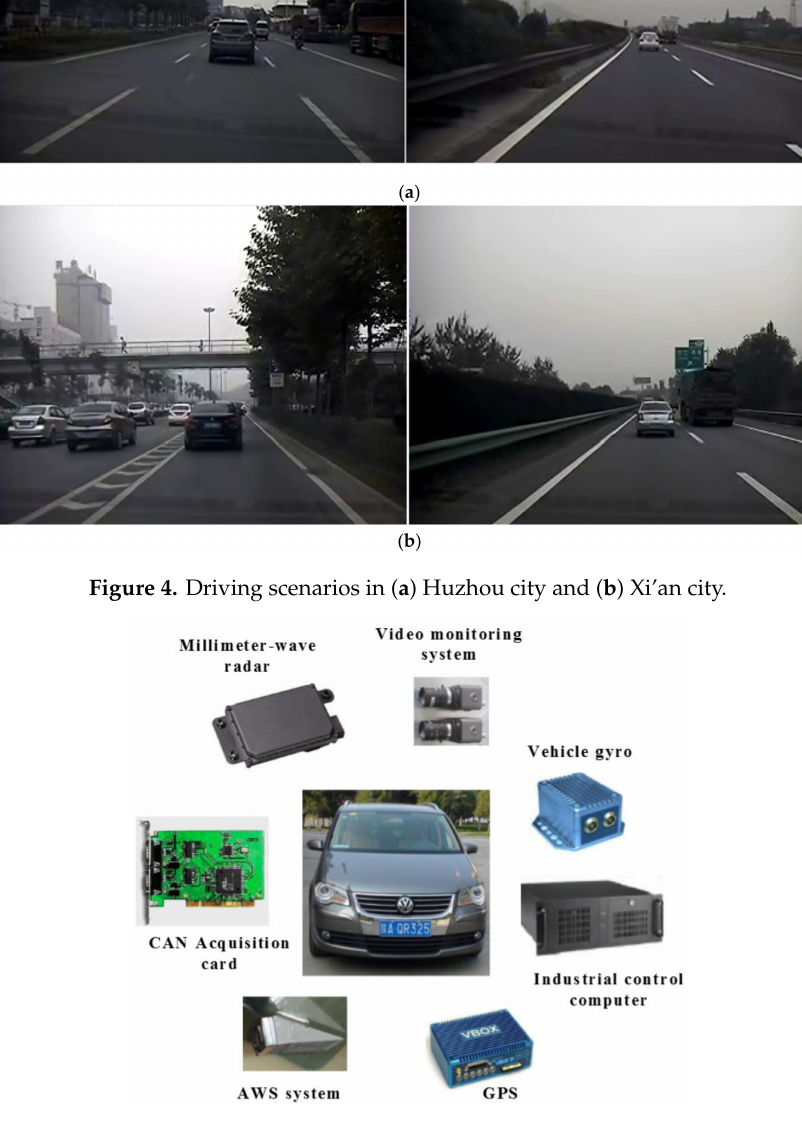
Figure 5. The test vehicle and related